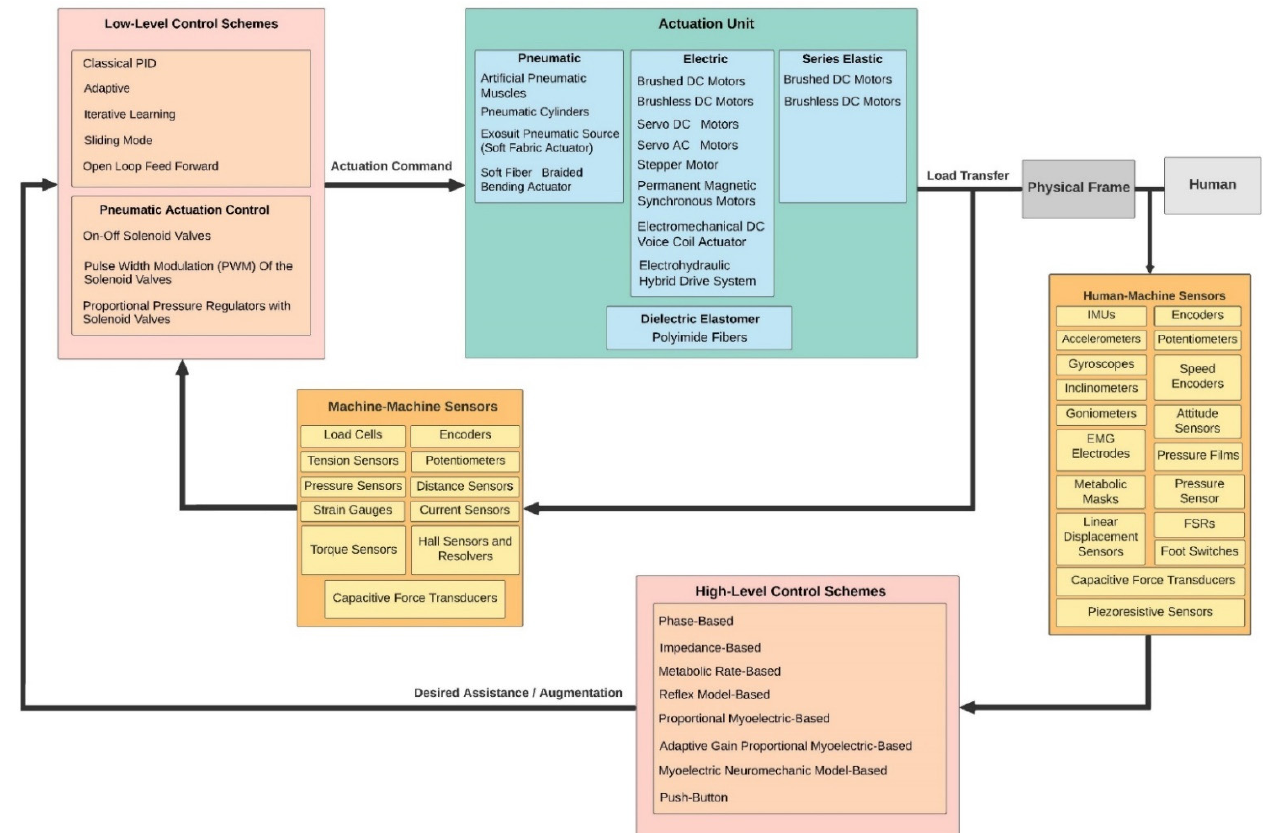
Figure 2. Schematic block diagram of the interaction between the main components of the PAEs. The list of different technologies and methods used in the reviewed literature for developing each component is provided in the corresponding block.